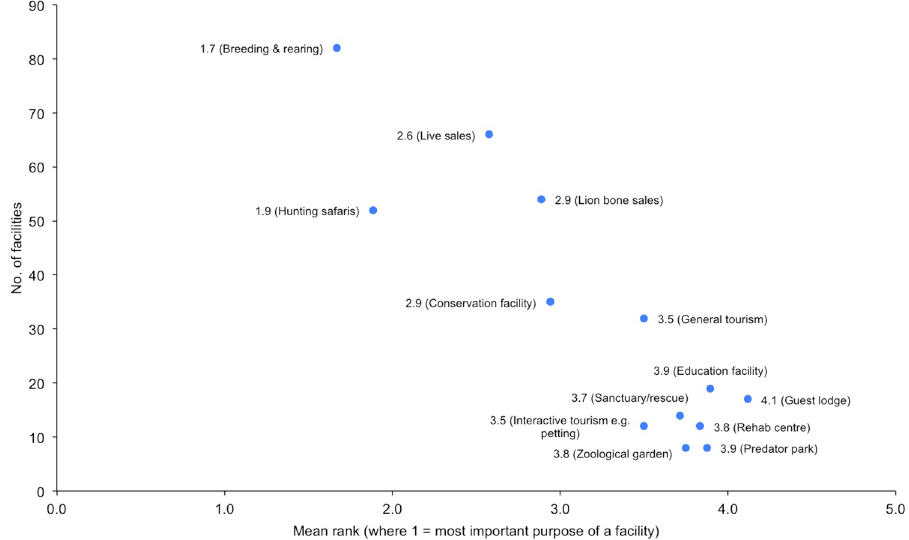
Fig 2. Core purposes of the facilities, expressed as the overall mean rank per purpose plotted against the number of facilities that ranked the purpose. Results correspond to Question 11. Respondents selected and ranked as many of the 13 pre-listed purpose categories that applied to their